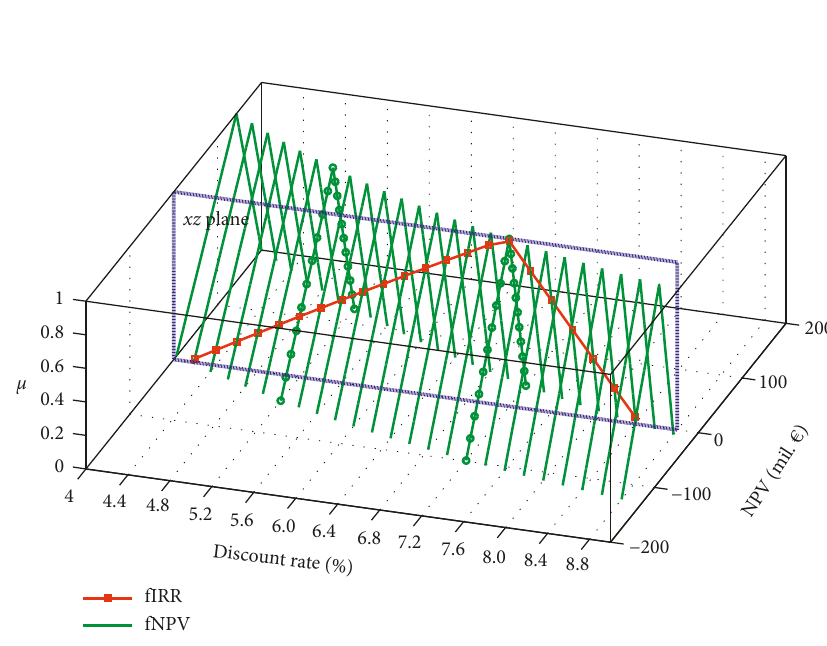
Figure 6: Calculation of fIRR.